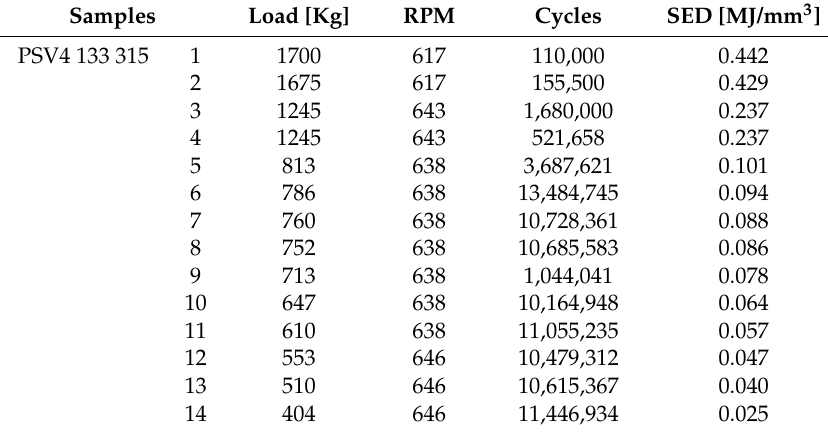
Table 9. Fatigue data for the roller PSV4 133 315 from